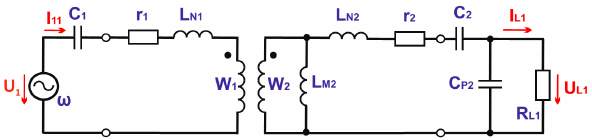
Figure 5. Compensation topologies of T-equivalent circuit.